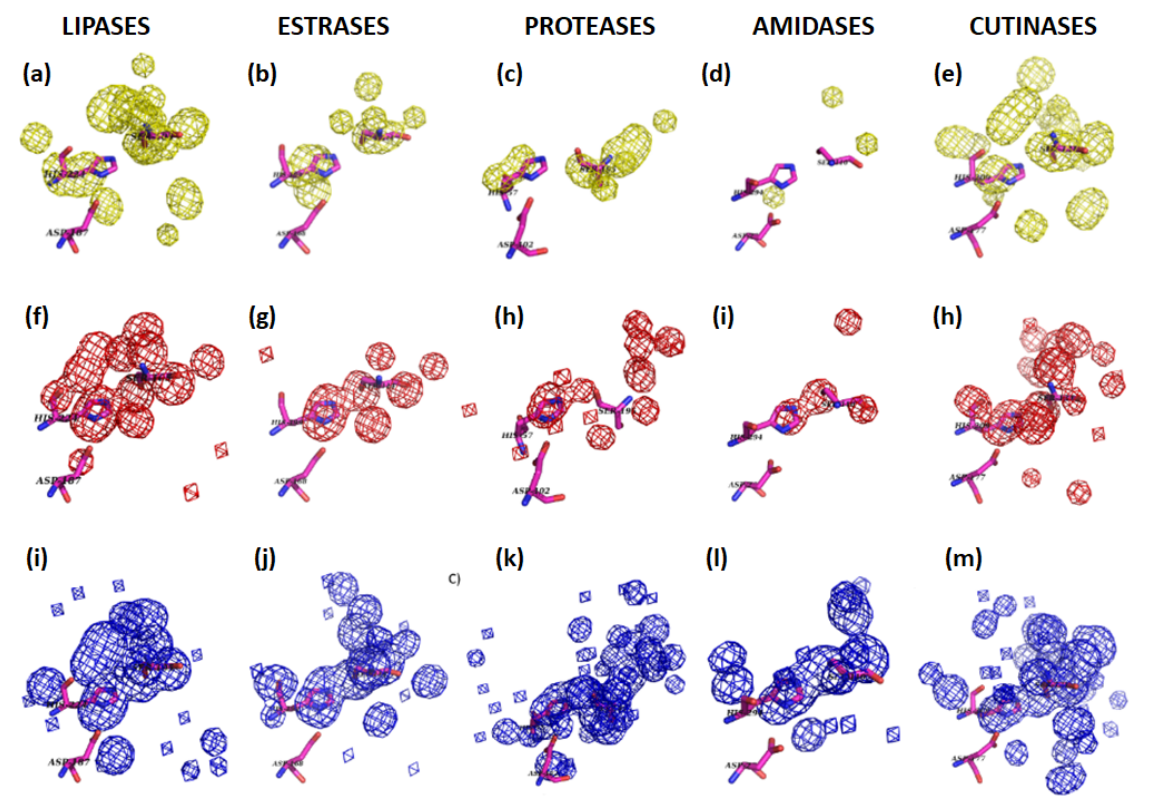
Figure 3. Calculated catalophores for each serine hydrolase sub-class. Color legend for catalophores calculated using the different probes: ( a – e ) DRY probe (hydrophobicity, yellow), ( f – h ) O probe (H-Bond donors, red), and ( i – m ) N1 probe (H-Bond acceptors, blue). For from left to right: lipases, esterases, proteases, amidases, and cutinases. The catalytic triad is highlighted on the back (licorice, magenta).